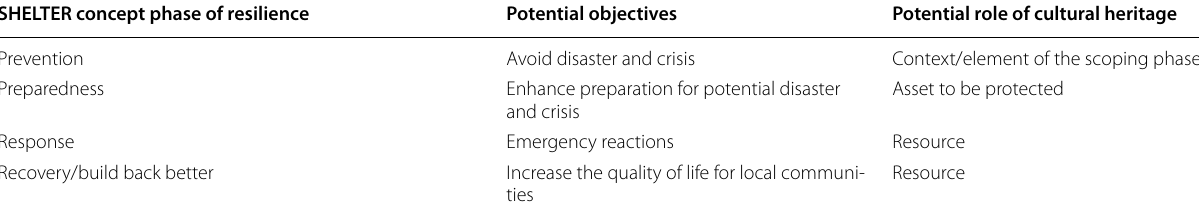
Table 2 Potential role of cultural heritage in the SHELTER concept of resilience. Based on SHELTER 2020 and our own considerations SHELTER concept phase of